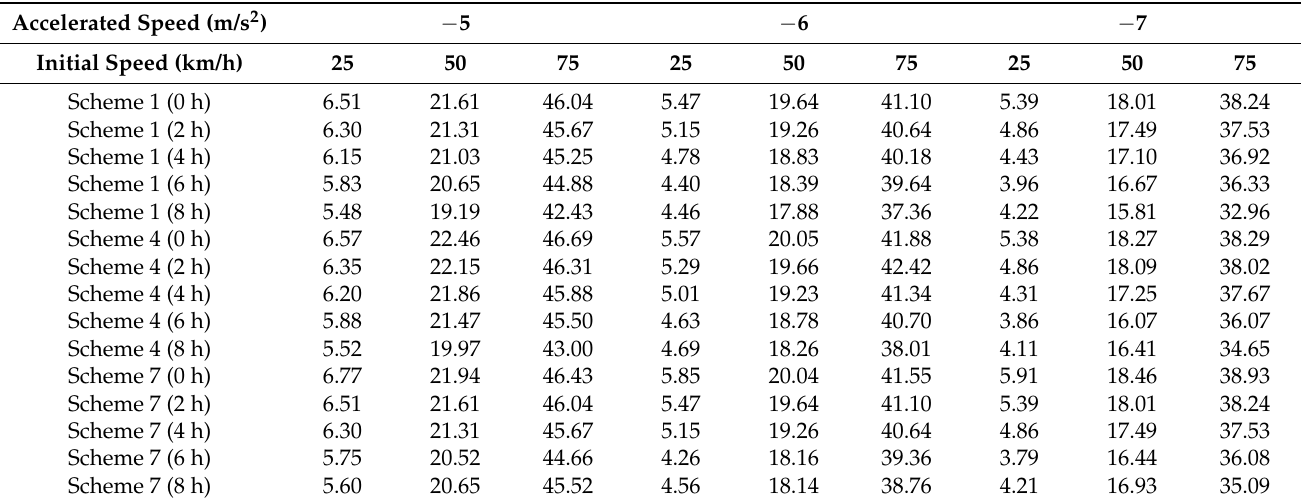
Table 7. Results for braking distance on dry pavement (m).